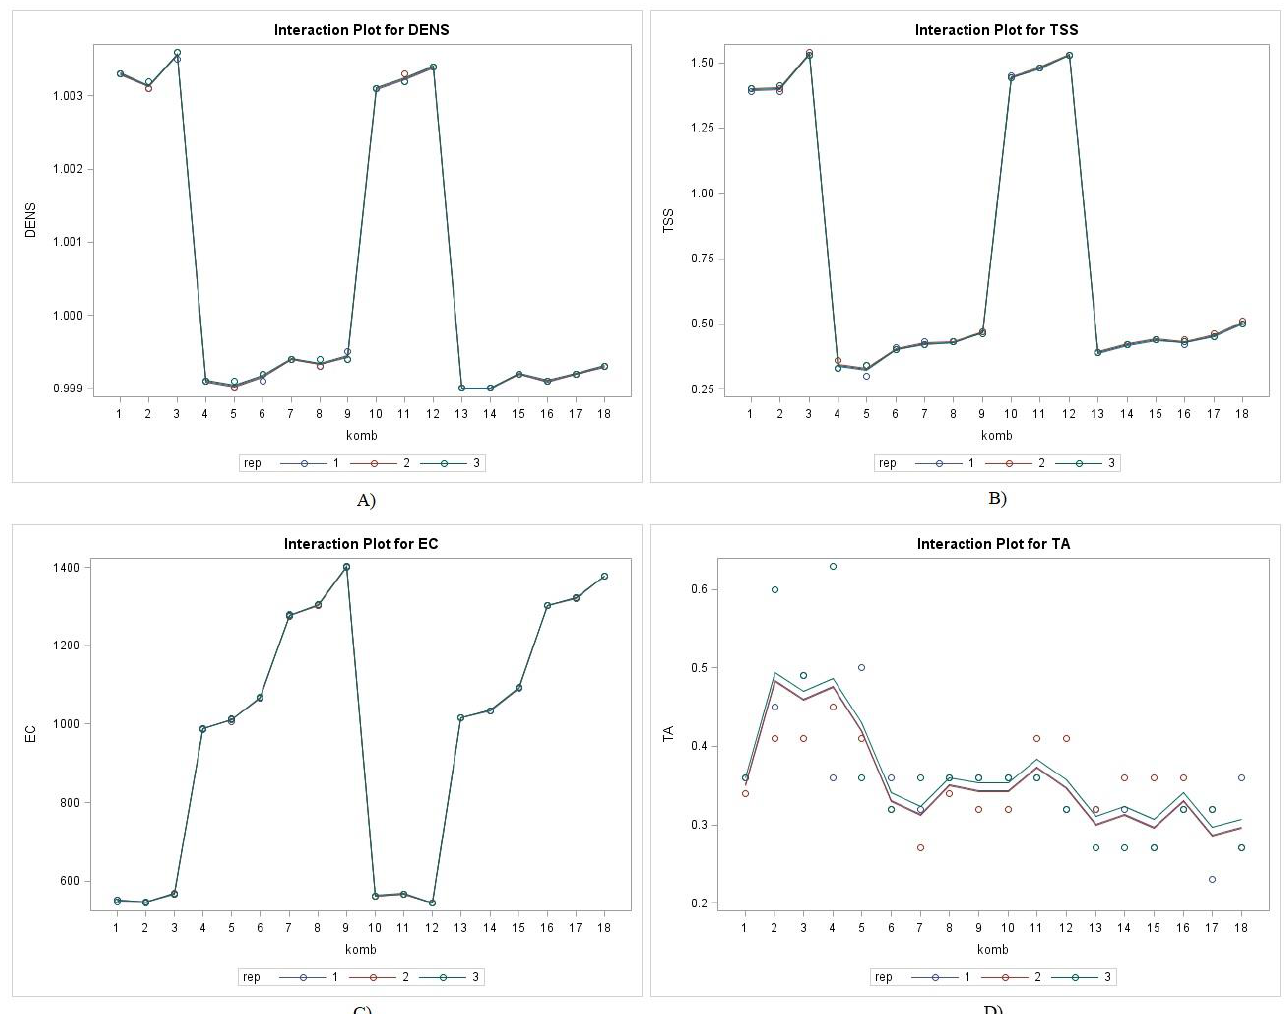
Figure 1. Physicochemical parameters: ( A ) density (g/cm 3 ); ( B ) total soluble solids (%); ( C ) electrical conductivity (µm/S); ( D ) total acids (%) of garlic (classic 1–3; UAE 10–12), ginger (classic 4–6; UAE 13–15) and turmeric (classic 7–9; UAE 16–18) extracts.